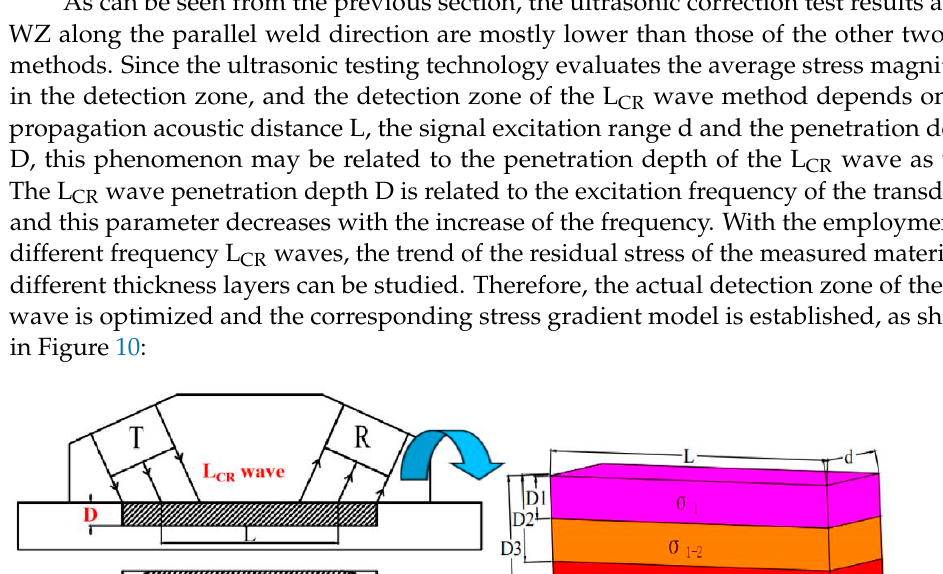
CR wave detection